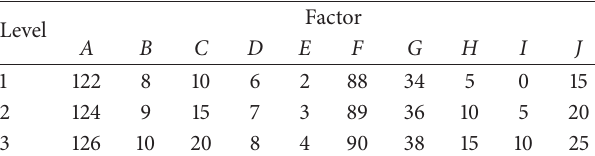
Table 2: Factor level